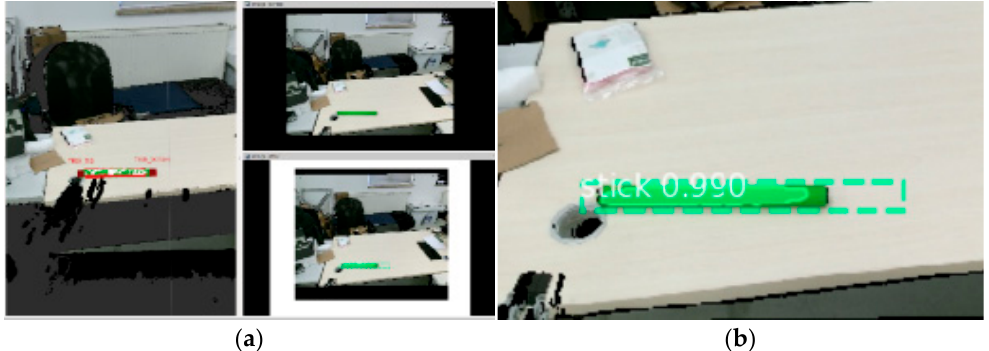
Figure 10. The identification result of Mask ‐ RCNN algorithm. ( a ) Mask ‐ RCNN can recognize the target in real ‐ time. ( b ) The recognition result of the Mask ‐ RCNN algorithm including Mask region , label , and confidence .